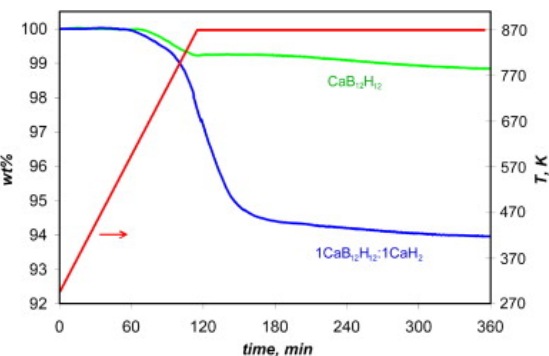
Figure 10. TGA curves for the desorption of CaB 12 H 12 (green curve) and ball-milled CaB 12 H 12 :CaH 2 (1:1) (blue curve). Reprinted from